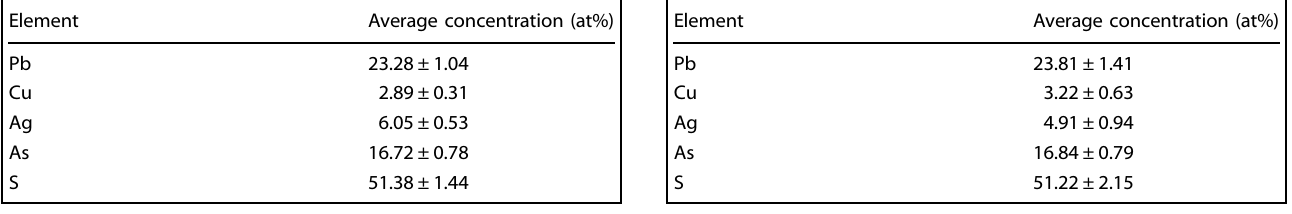
Table 1. Compositional stoichiometry of lengenbachite from EDXS quanti fi cation. Element